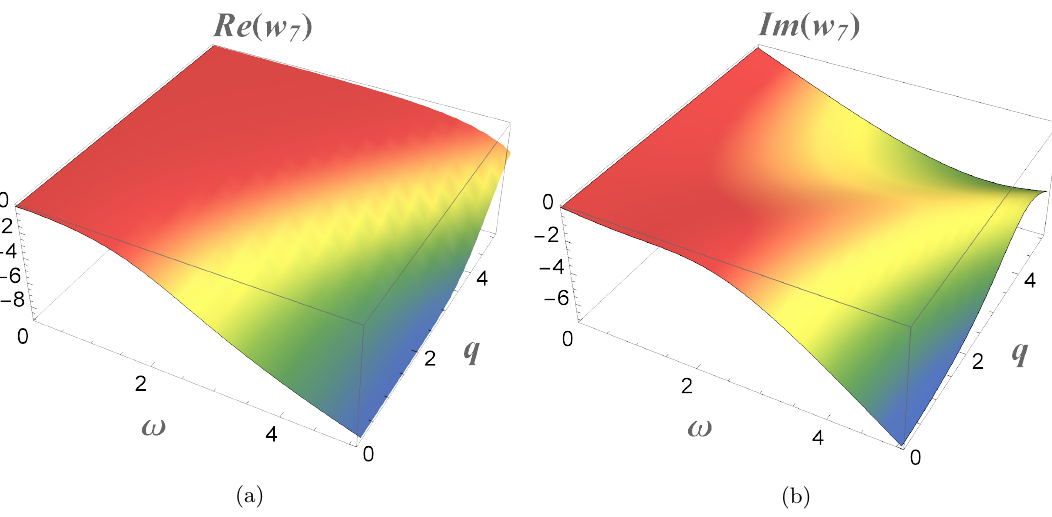
Figure 9 . Plots for ω -, q -dependence of the coefficients (a) Re ( w 7 ( ω, q )) , (b) Im ( w 7 ( ω, q ))